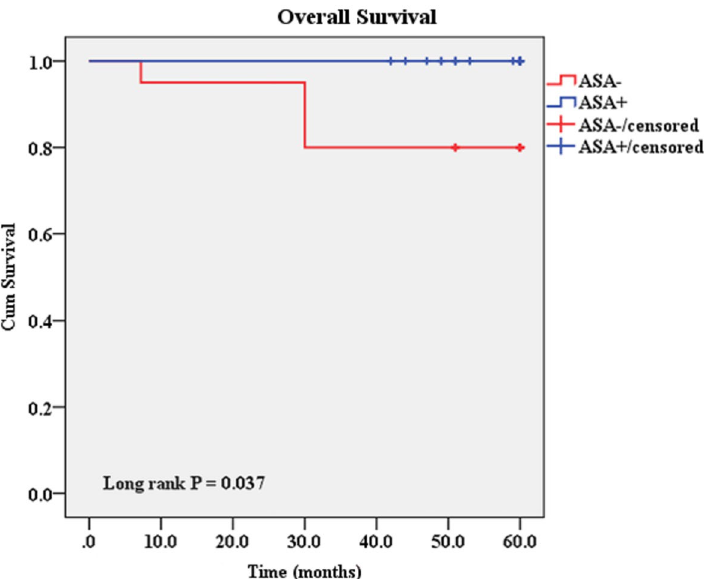
Figure 9. A Kaplan–Meier analysis of 5-year overall survival between the Aspirin and non-aspirin groups. A longer overall survival rate was seen after aspirin